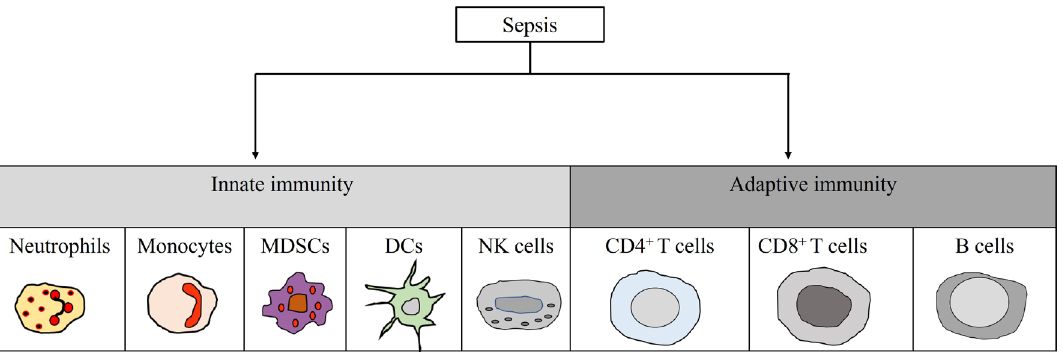
Figure 2. The major immunosuppressive players of innate and adaptive immune system during sepsis. MDSCs: myeloid-derived suppressor cells; NK: natural